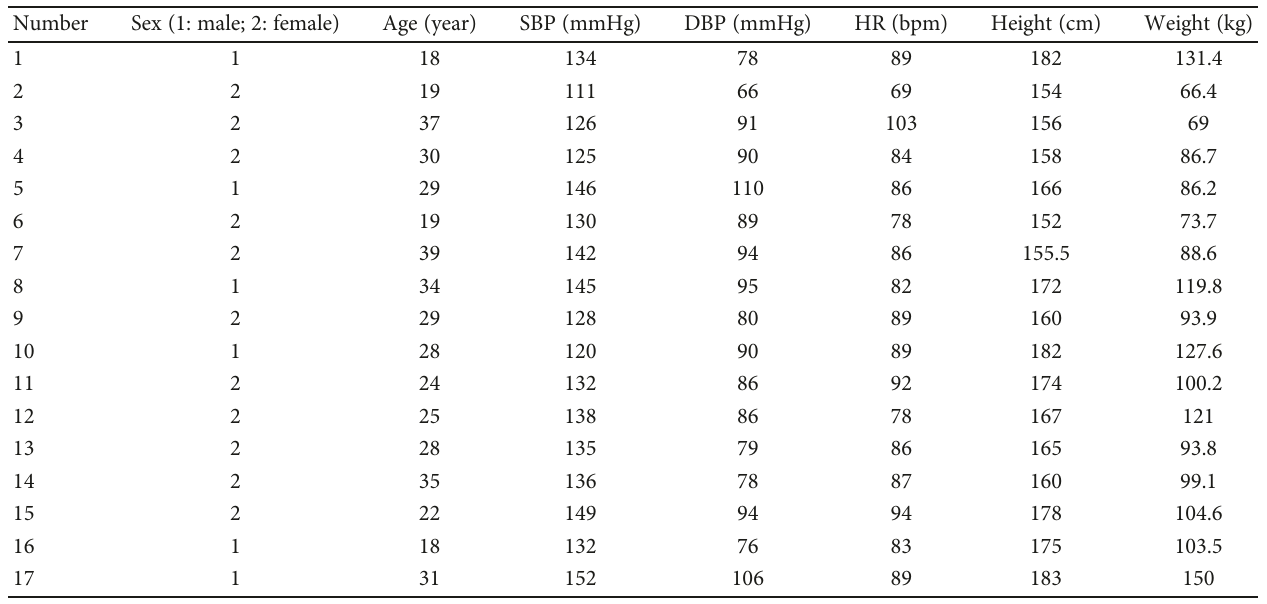
Table 3: Baseline of